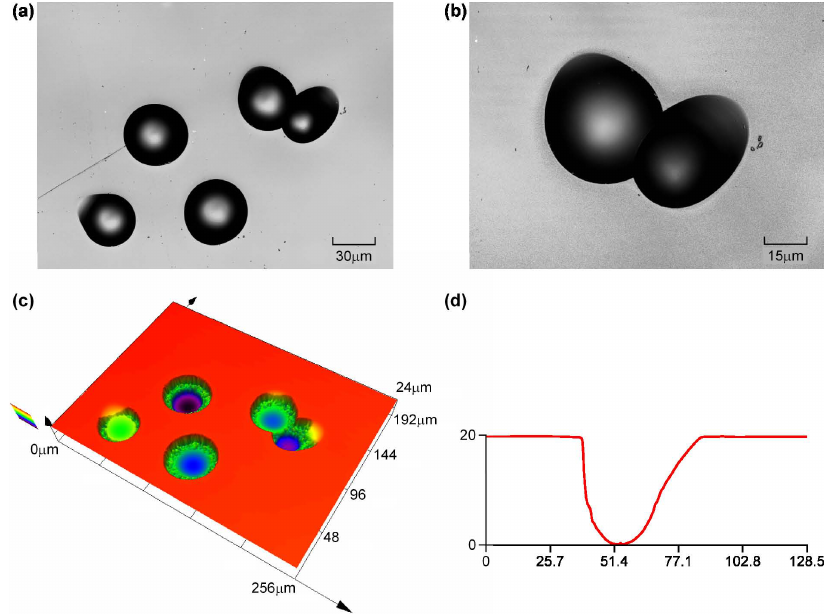
Fig. 2. Example of 3-D visualisation of tracks from data showing the distribution of single isolated tracks and two coalescing tracks. (a) shows the view from the top surface obtained with a × 50 objective and (b) shows a close up image of the two coalescing tracks obtained with a × 100 objective. (c) shows a side view height encoded colour image with red being the top, through yellow, blue, green to purple being the deepest. (d) shows the height profile variation for the right track forming the two coalescing tracks. The profile is from left to right through the track’s long axis and shows a steeper slope on the left hand side compared with the right hand side suggesting that the particle hit the detector from the right.